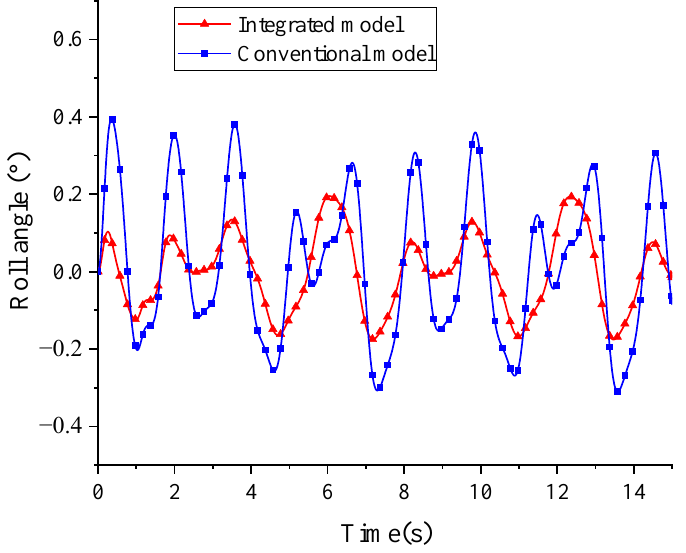
Figure 9. Comparison curve of vehicle roll angle under sinusoidal signals. Table 3. Peak–peak value of vehicle attitude under sinusoidal signals. Vertical